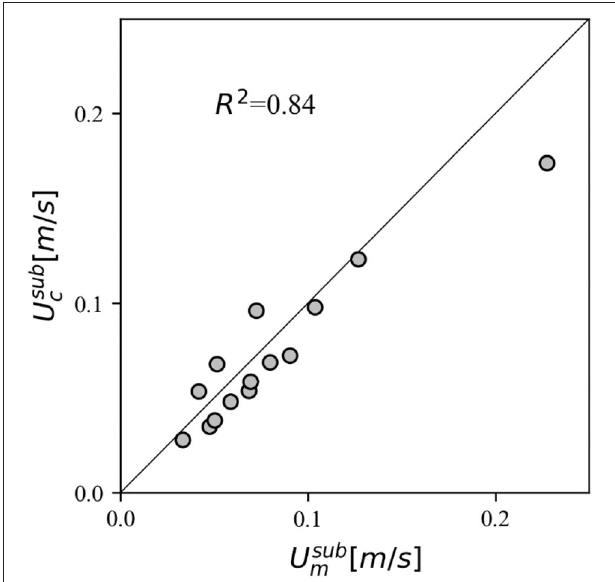
FIGURE 8 | The strong agreement between predicted and measured drag forces, including the line of perfect agreement (dashed). The predictive model skill is described by the relative bias and scatter index (bottom right corner).